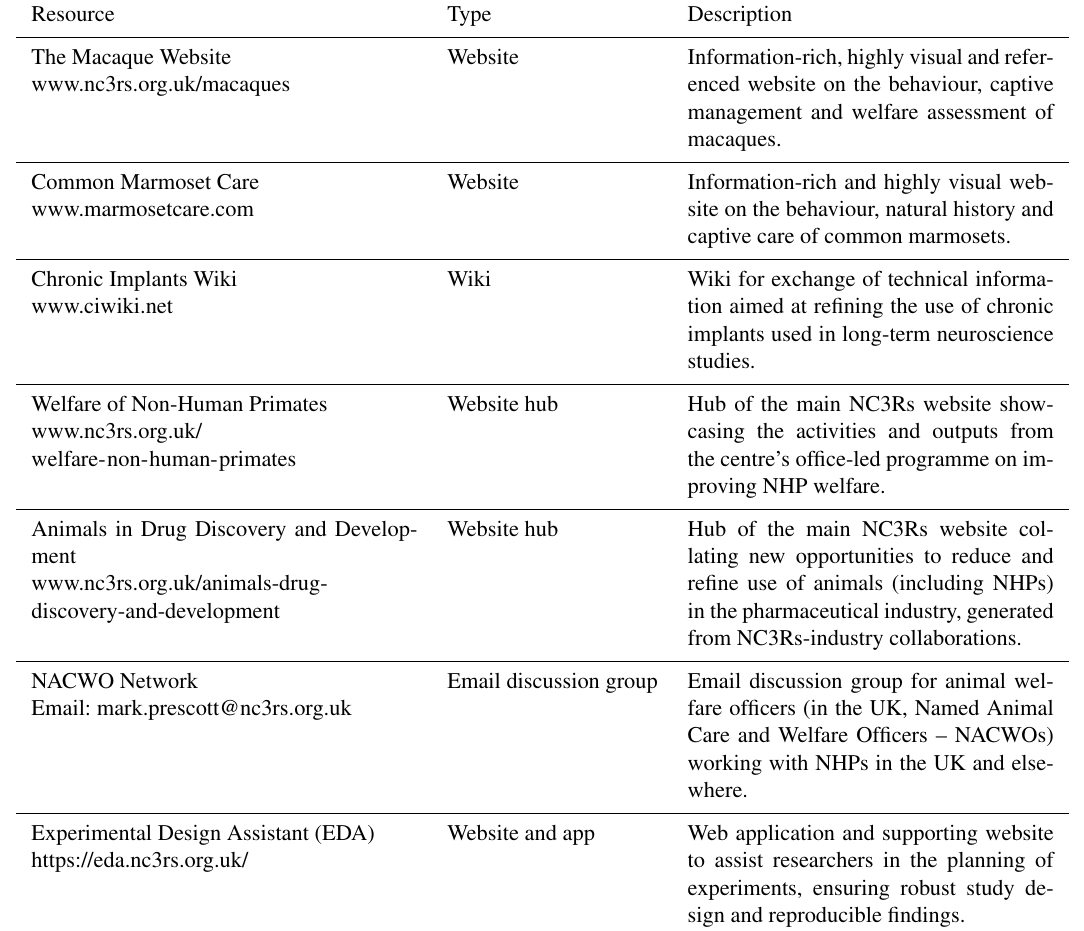
Table 1. Summary of NC3Rs online resources relevant to the care and use of